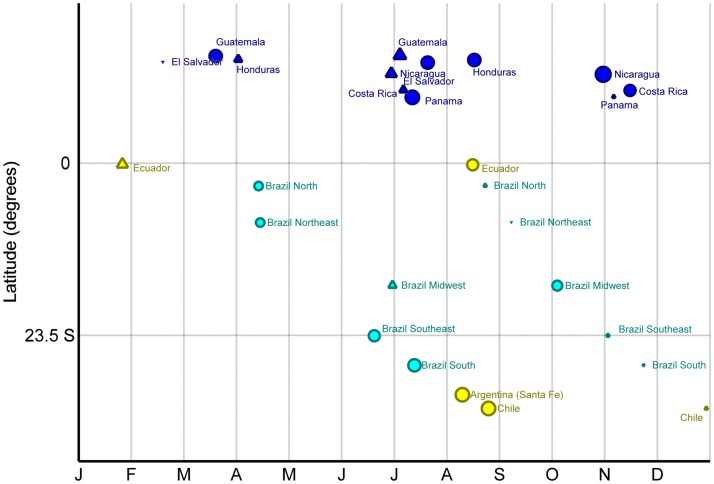
Timing and amplitude of primary (circles) and secondary (triangles) peak of influenza detection by site, against their latitudinal position.The size corresponds to the amplitude of influenza seasonality. Dark Blue: Central America. Light Blue: Brazil. Yellow: remaining sites in South America.